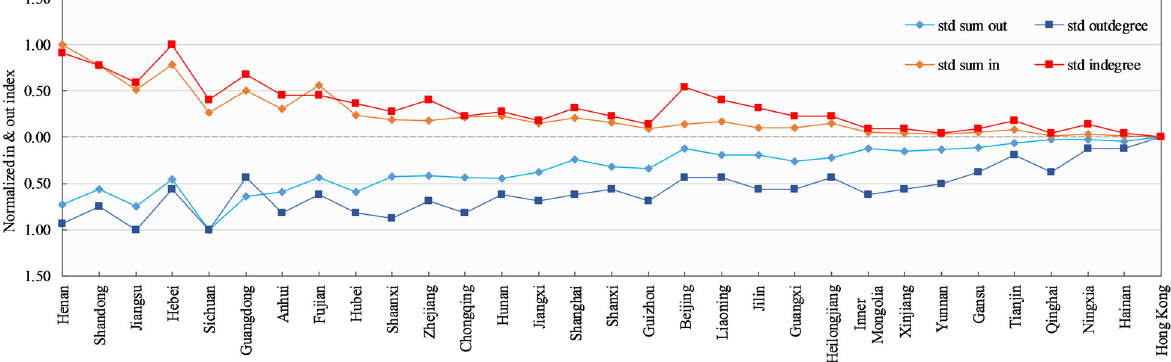
Fig. 3 Standardized quantity and degree of informal adoptions. Since the total number and degree of informal in- and out-adoptions are different, the raw data are incomparable. The normalized indexes are therefore used to select source and